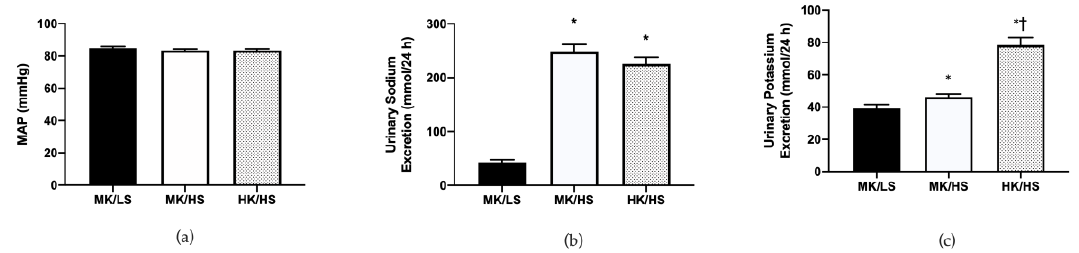
Figure 1. ( a ) Mean arterial pressure (MAP) on the last day of each diet. ( b ) Urinary sodium excretion increased on the high sodium diets compared to low sodium. ( c ) Urinary potassium excretion was elevated on the high potassium diet compared to the moderate potassium diets, however there was a difference in potassium excretion between the high and low sodium diets. HK/HS, high potassium/high sodium; MK/HS, moderate potassium/high sodium; MK/LS, moderate potassium/low sodium. Values are mean ± SE; * p < 0.05 vs. MK/LS; † p < 0.05 vs. MK/HS.